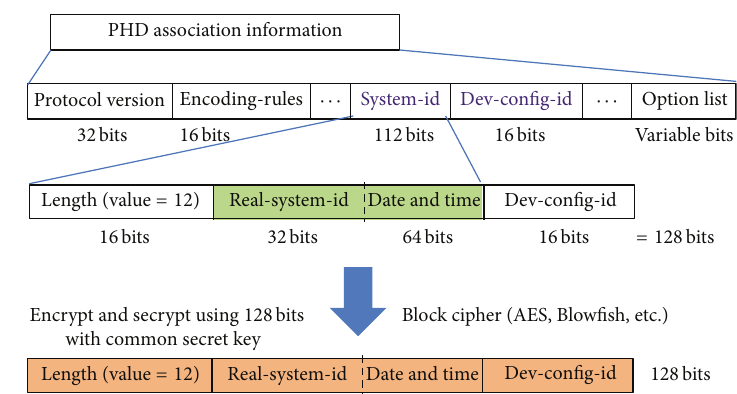
Figure 4: The proposed privacy protection